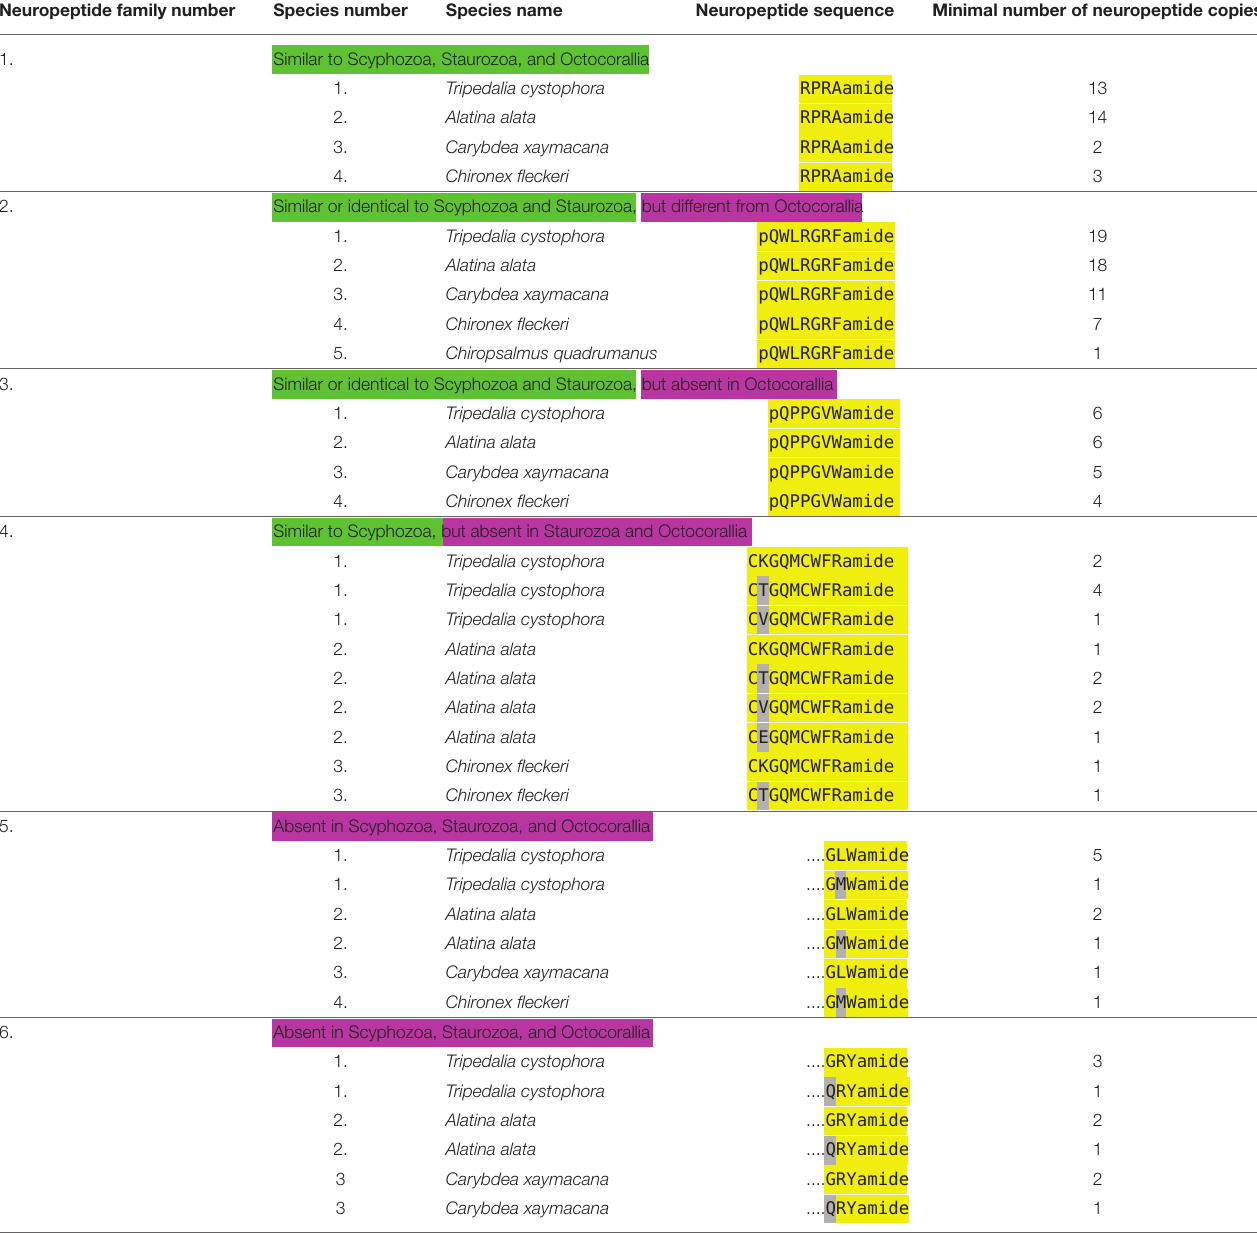
TABLE 4 | An overview of cubozoan neuropeptide